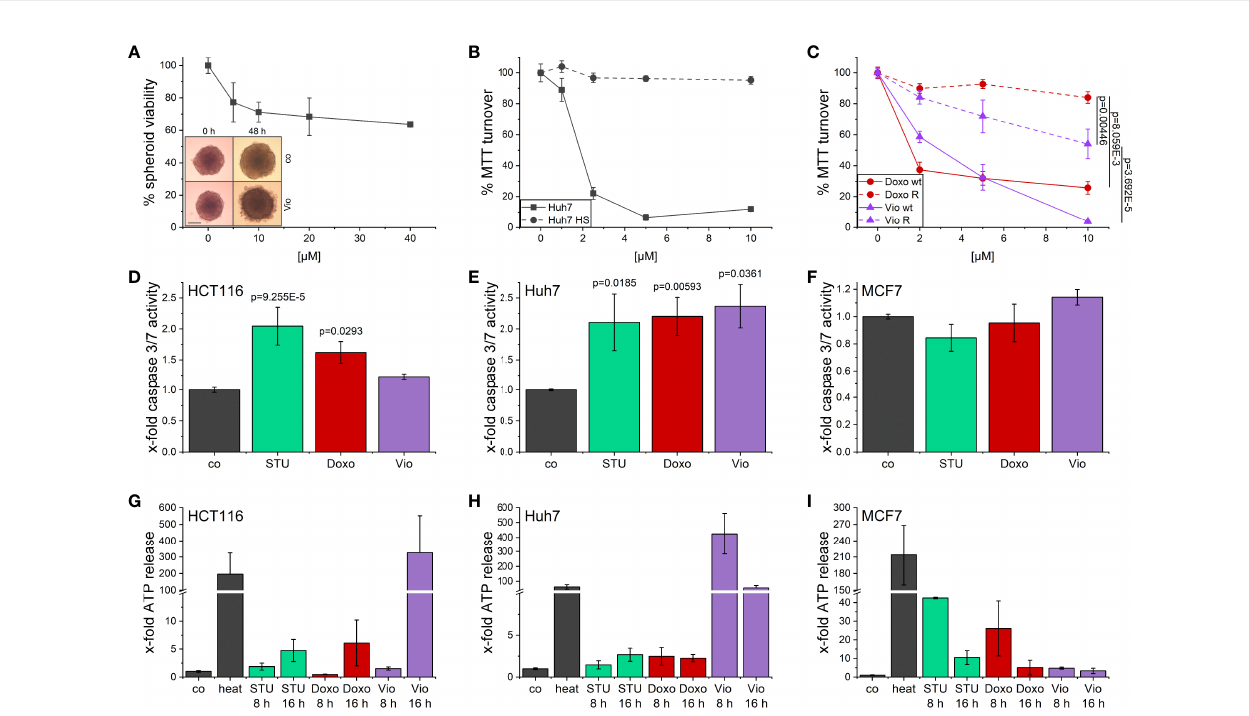
FIGURE 1 | Cytotoxic effects of violacein against cancer cells. (A) HCT116 spheroids were treated with violacein or DMSO solvent control for 48 h before spheroids were imaged and cellular viability was analyzed. Representative pictures for the DMSO control (co) and 20 µM violacein treatment are shown for the start and treatment endpoint; scale bar = 250 m m. (B) Standard Huh7 or human serum (HS)-differentiated Huh7 cells were treated with violacein or solvent control (set to 100%), and cells were analyzed in an MTT assay 48 h after treatment. (C) Doxorubicin resistant (R) and Huh7 wildtype (wt) cells were treated with violacein (Vio) or doxorubicin (Doxo), and cells were analyzed by MTT assay 48 h after treatment. (D-F) Caspase 3/7 activity of (D) HCT116, (E) Huh7, and (F) MCF7 cells treated for 8 h with staurosporine (STU, 1 µM), doxorubicin (5 µM), or violacein (10 µM), respectively. (G-I) Luciferase-based measurement of ATP release to the supernatant of (G) HCT116, (H) Huh7, and (I) MCF7 cells treated for 8 h or 16 h with staurosporine (STU, 1 µM), doxorubicin (Doxo, 5 µM), or violacein (Vio, 10 µM), respectively. D-I: Means values for solvent-control treatment were set as